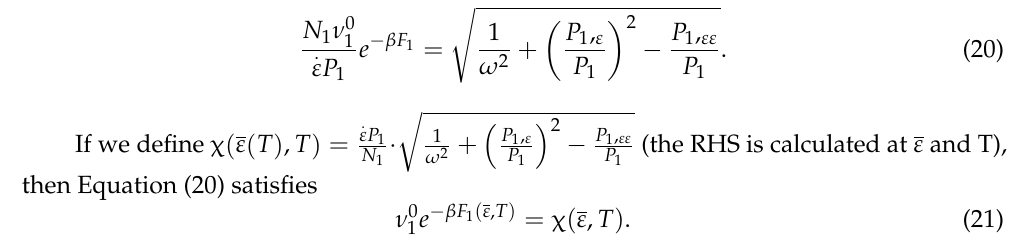
Figure 7. 𝑙𝑛(cid:4666)𝜒(cid:4667) as a function of (cid:3435) 1 (cid:3398) 𝜀 𝜀 (cid:3030)(cid:3045) 𝑇 → ∞ is plotted. (cid:3040)